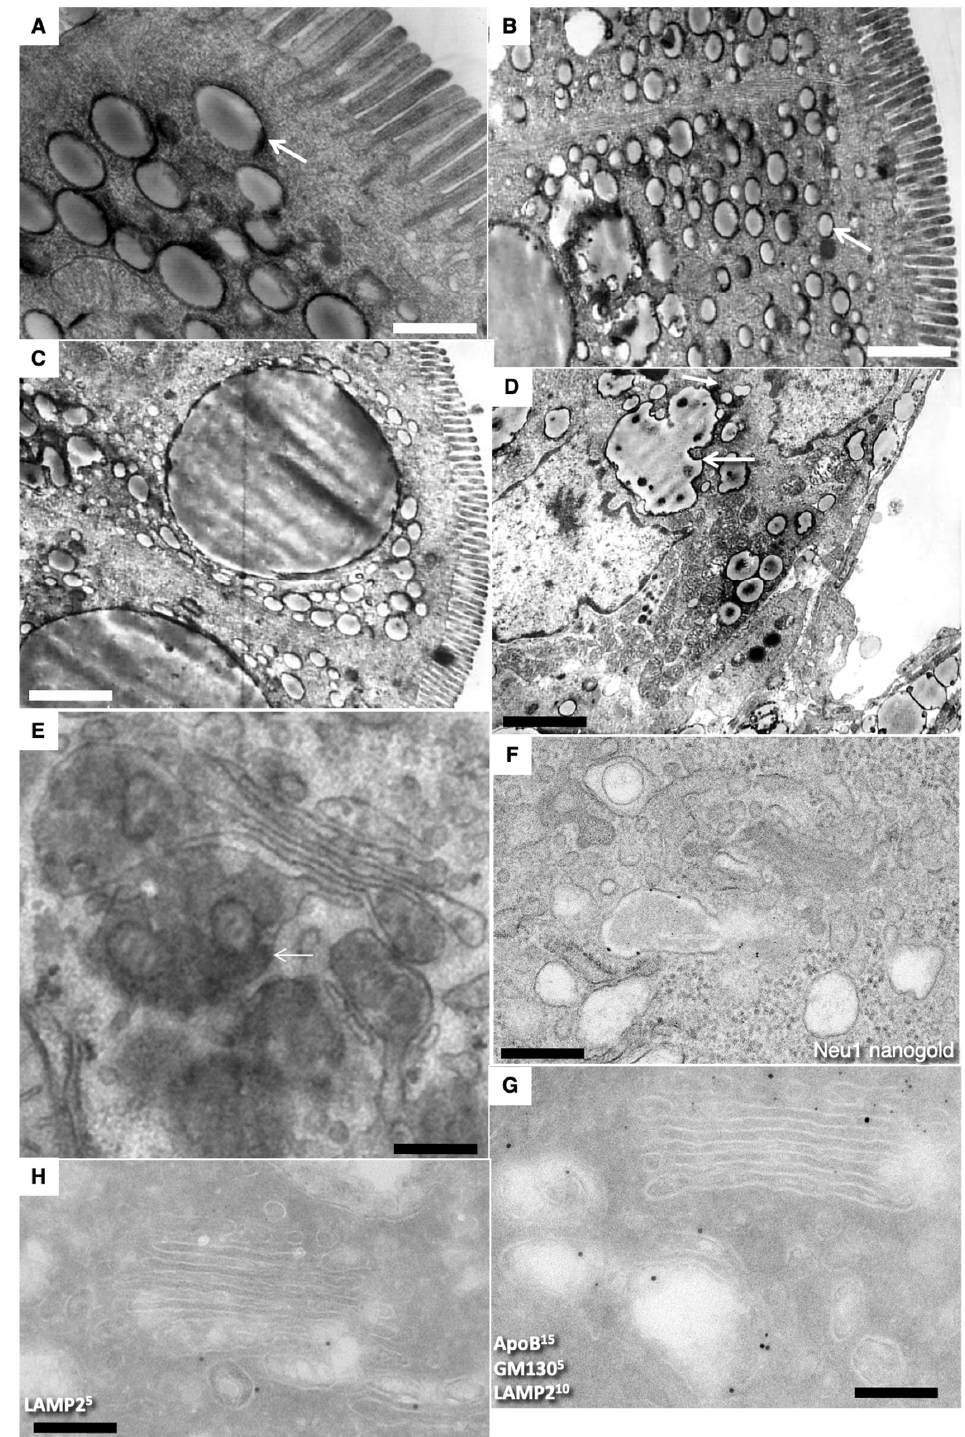
Figure 5. Structure of enterocytes in newborn rats after their first feeding. ( A – C ) Formation of large lipid droplets (white arrows) in the cytoplasm. ( D ) Formation of “lipid lakes” (black arrows) between enterocytes after the first feeding of a newborn rat. ( E ) Overloading of the GC. ( F ) Large ChMs in post-Golgi compartment positive for Nau1. ( G , H ) Labeling for LAMP2, GM130 and ApoB of post-Golgi carriers containing large ChMs. Scale bars: 510 nm ( A ); 1020 nm ( B ); 1.3 µm ( C ); 1025 nm ( D ); 240 nm ( E ); 340 nm ( F ).